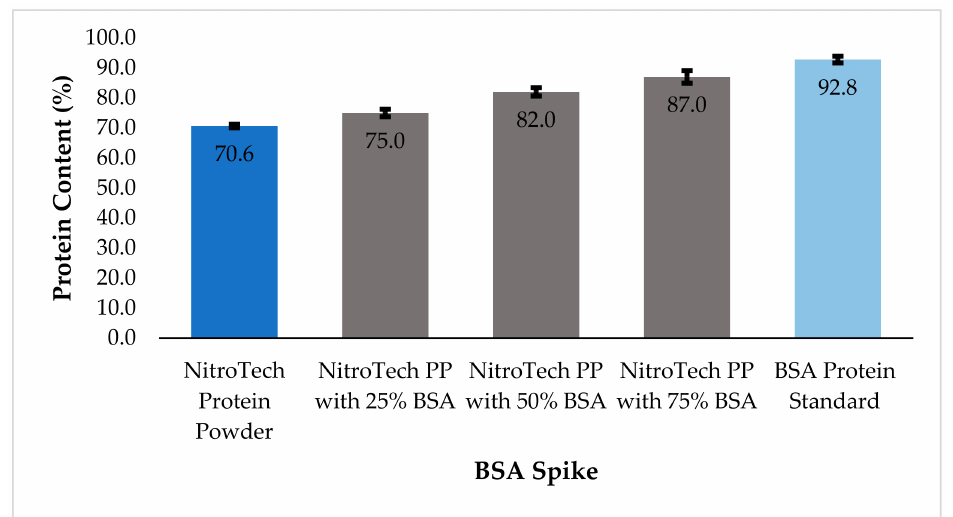
Figure 4. Bar graph showing percent protein values for 100% NitroTech protein powder (NitroTech PP) and each subsequent BSA spike (25%, 50%, and 75%), as well as the 100% BSA protein standard. Standard deviation is shown for each, error bar based on a sampling size of 5 measurements of a 2.0 g